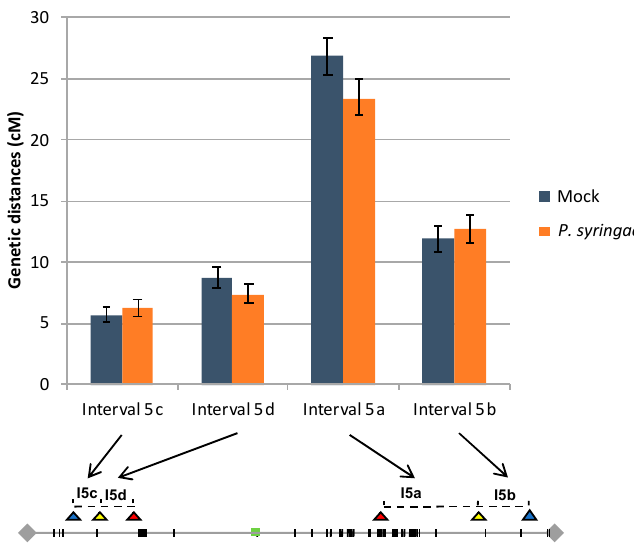
Figure 4. Recombination rate in control and infected plants. Recombination frequencies were calculated for each interval I5cd and I5ab, in infected and in control plants. The distribution of NLR genes and Fluorescent Tags on chromosome 5 are depicted in Figure 1 (see legends in Figure 1).